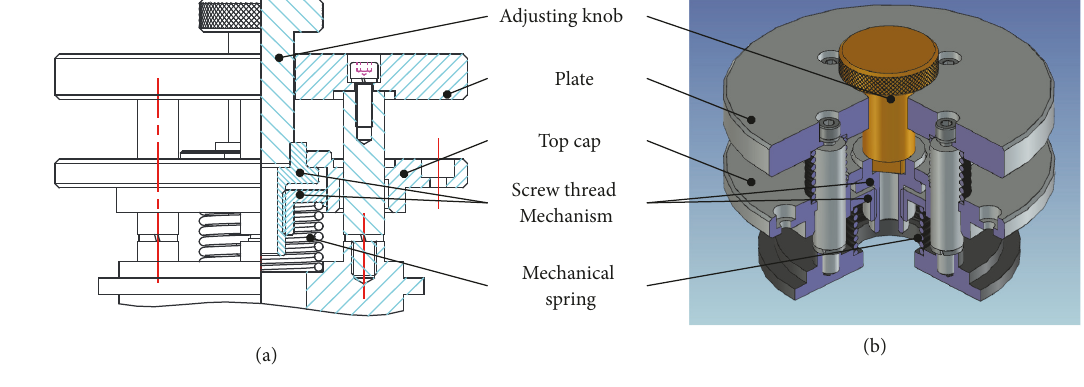
Figure 8: Regulating mechanism of active cell position.